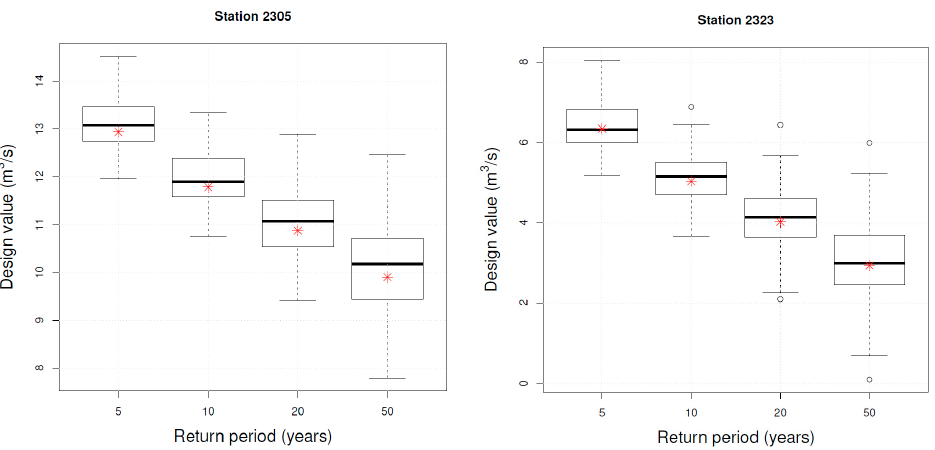
Figure 9. Middle Çoruh basin. Estimates of the univariate low-flow design values (red asterisks) associated with different return periods. Additionally shown are Monte Carlo boxplots providing an estimate of the corresponding uncertainty—see text.